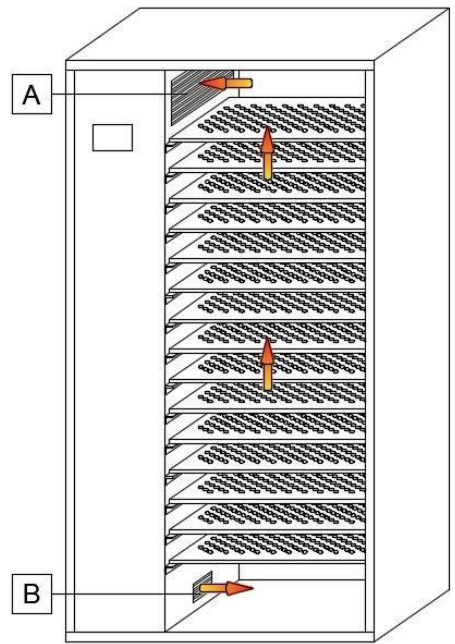
Figure 1. Diagram of air flow through a classic drying chamber, without modification. A—air inlet; B—air outlet. The arrows indicate the direction of the air flow.